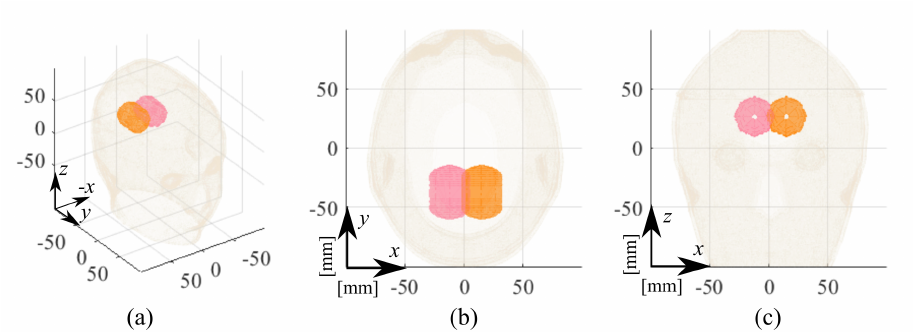
Figure 5. HP estimated stroke position in the experimental testing: I, pink capsule; II, orange capsule. ( a ) Three-dimensional view, ( b ) transverse view, and ( c ) frontal view.